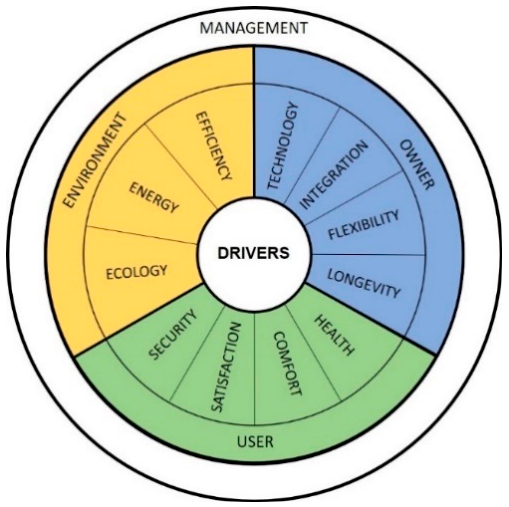
Figure 5. Smart buildings’ drivers grouped by category.